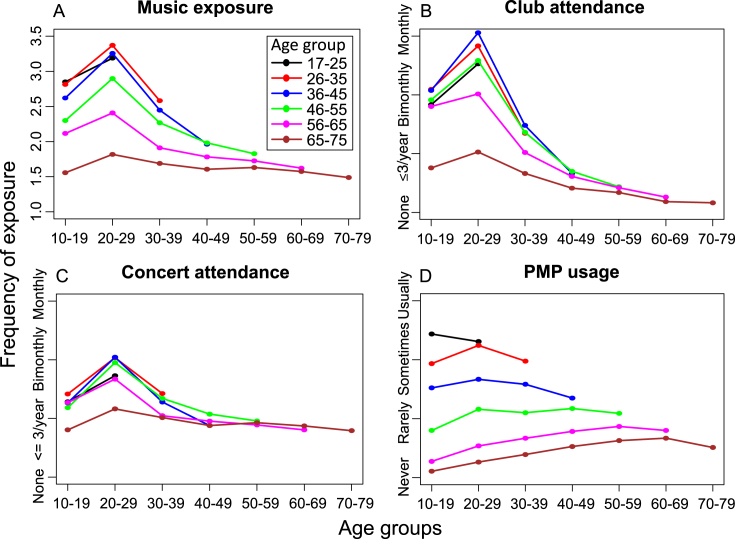
Relation between type and amount of music exposure by age decade. A. Total music exposure, and B-D. Each type of music exposure. Mean data points derived as per Methods.